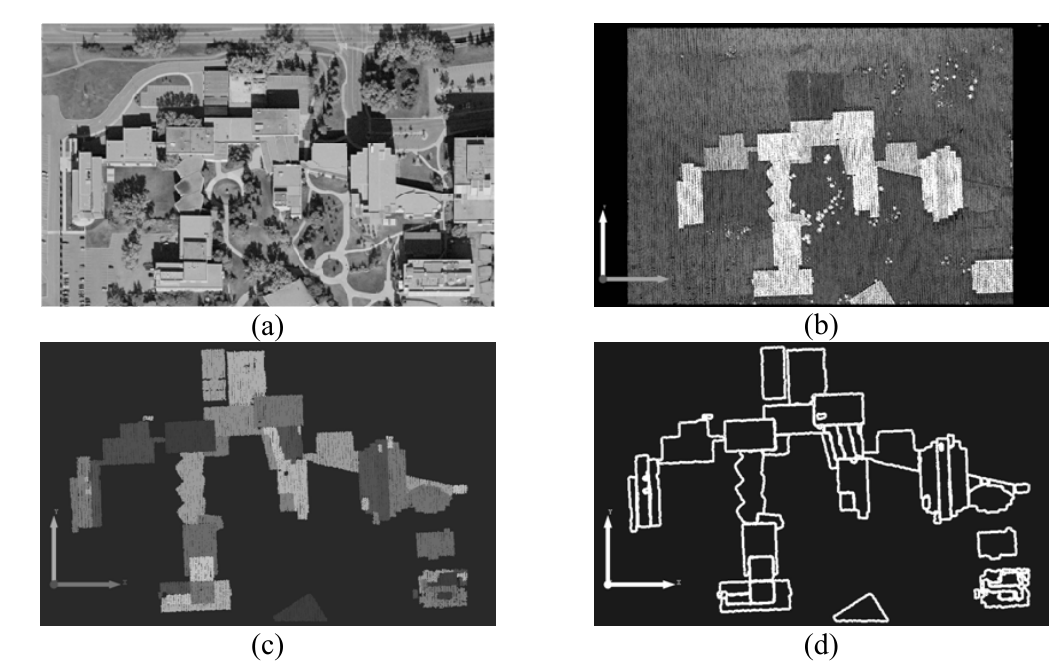
Figure 13. (a) Aerial photo over the area of interest; (b) LiDAR points over the same area; (c) clustered building primitives; and (d) the initial boundaries of the building